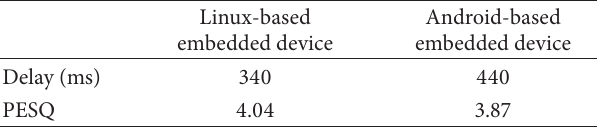
Table 2: The delay and PESQ between the host and the receivers.